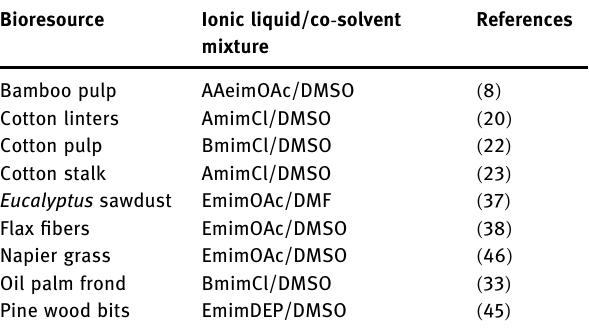
Table 4: Examples of bioresources and imidazolium - based ionic liquid/co - solvent mixtures employed for the isolation of cellulose